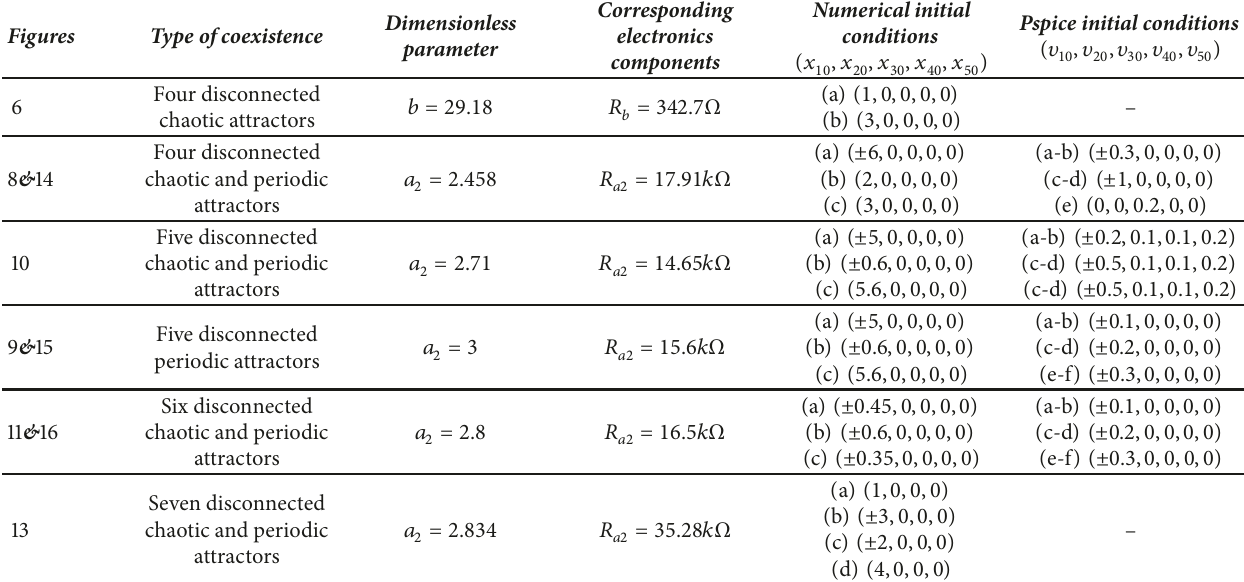
Table 2: Initial conditions for the abundant coexisting